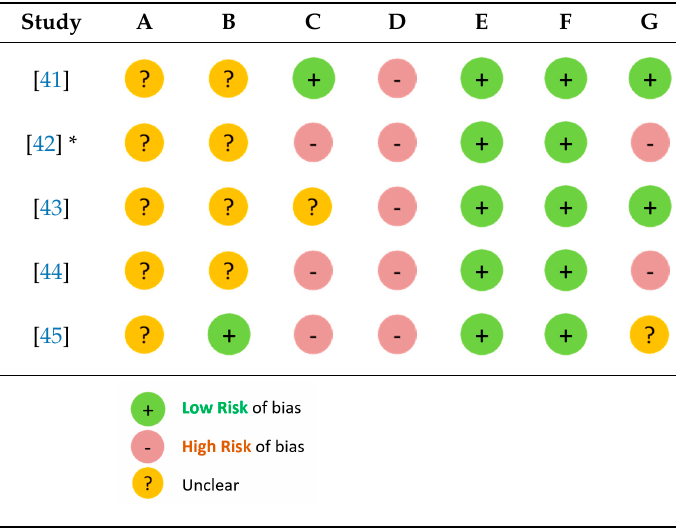
Table 4. Quality assessment of the included studies. Cross-over studies where A = Randomized treatment order; B = Carry-over effect; C = Performance bias; D = Detection bias; E = Attrition bias; F = Reporting bias; G = Other bias. * Parallel studies where A = Random sequence generation and B = Allocation